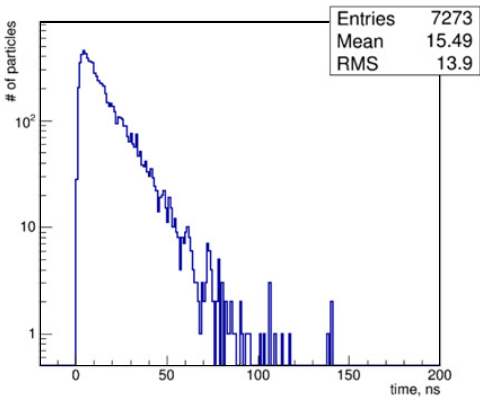
Figure 3. Charged particles arrival time at 50 m from EAS core.